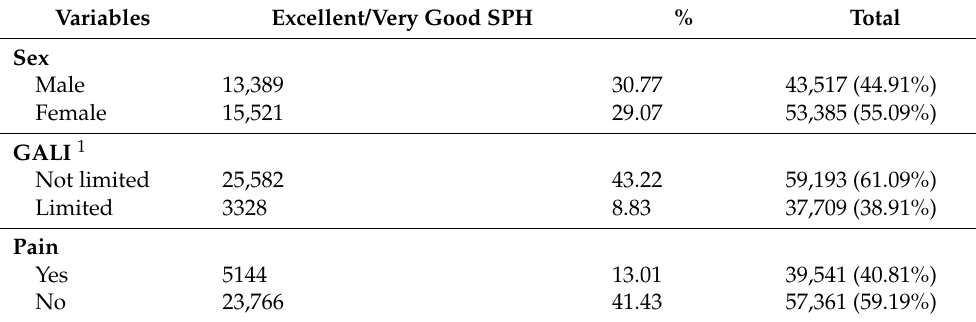
Table 3. Overview of the distribution of the rating of categorical